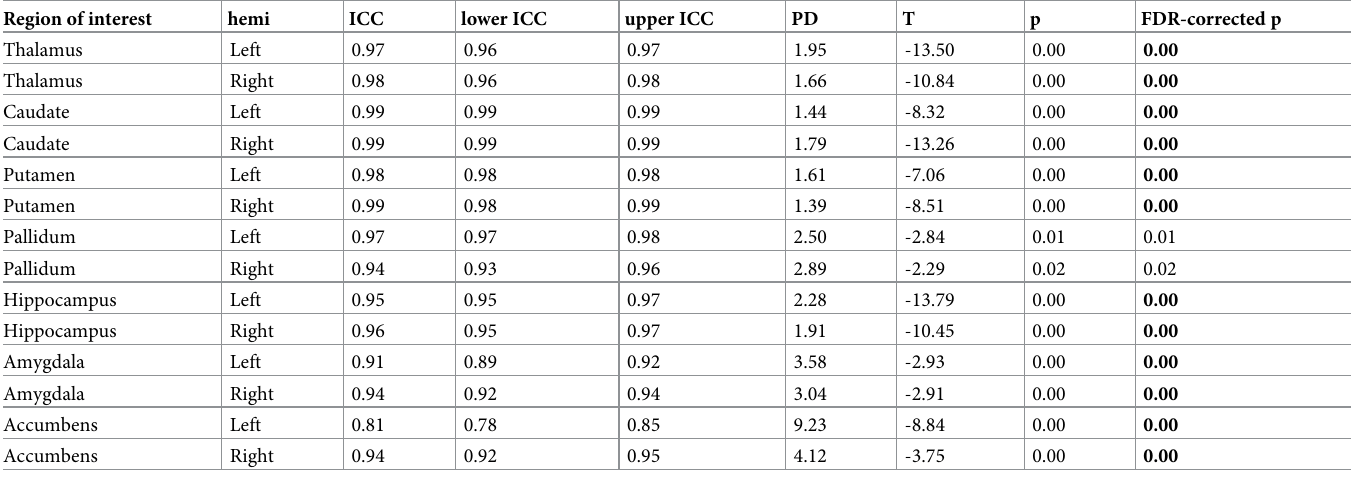
P-values are shown uncorrected, and FDR-corrected where bold indicates p <